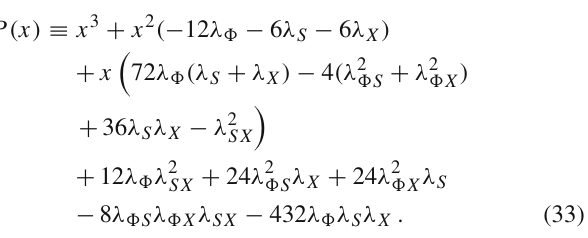
Fig. 1 Decay branching ratios of a SM-like Higgs boson, h SM , for var- ious SM particle final states, F SM , as a function of its mass, M h the mass range from 1 GeV to 1 TeV, split into the low mass region ( left